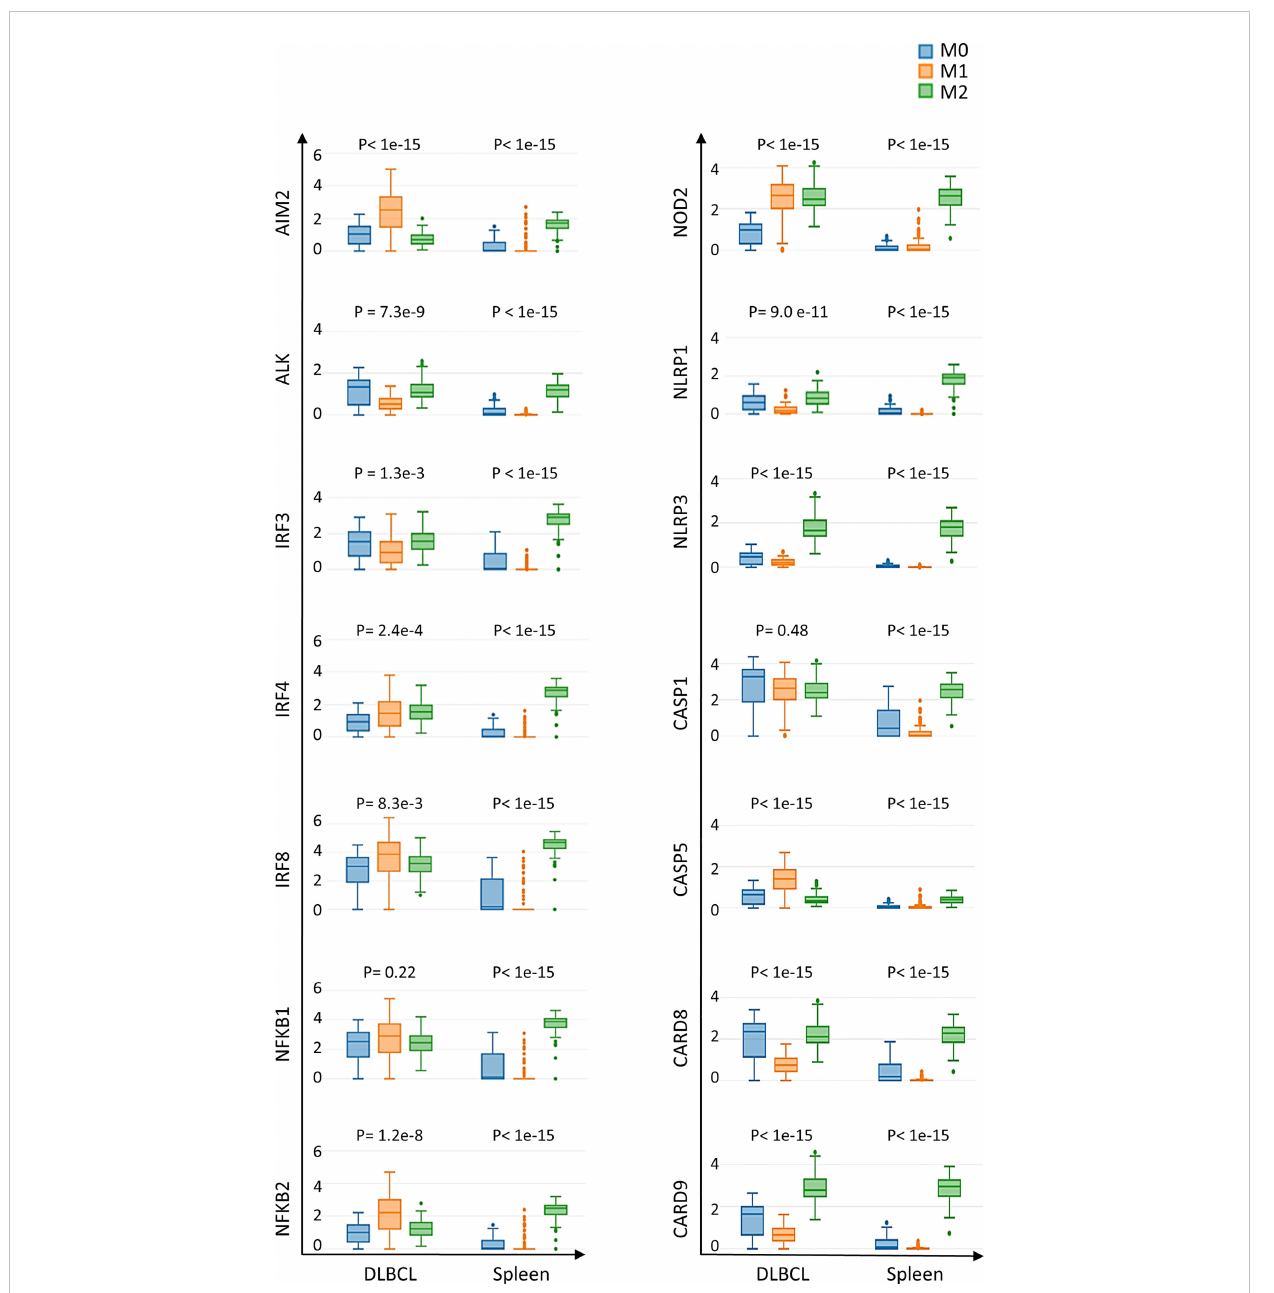
FIGURE 3 Differential expression of in fl ammasome components in M0, M1 and M2 macrophages in DLBCL and spleen samples. Comparison of the gene expression of key in fl ammasome molecules in M0, M1 and M2 macrophages in 47 DLBCL samples (TCGA database) and 337 spleen tissue samples (normal secondary lymphoid organ tissue; GTEx database) Y-axis: log (TPM+1) of the gene expression level. Additional data are in Table 1. Signi fi cance: P ≤ 0.05 (one-way ANOVA). TPM, transcript count per million reads. It is important to note that the results of the deconvolution analyses in Figures 3, 4 display comparisons according to the tissue type (DLBCL and spleen) and not the cell type (M0, M1 and